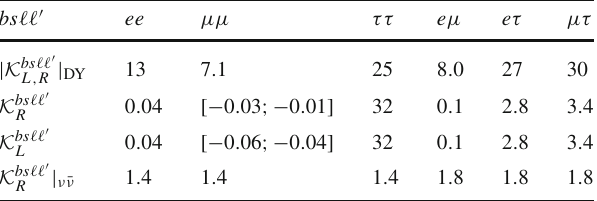
Table 4 Upper limits on charged dilepton couplings K bs (cid:4)(cid:4) (cid:2) p T [14,15] (top row), charged dilepton B -decays (middle rows) and derived ones from three-body rare B -decays to dineutrinos (bottom). Numbers without ranges correspond to a limit on the modulus. the μμ